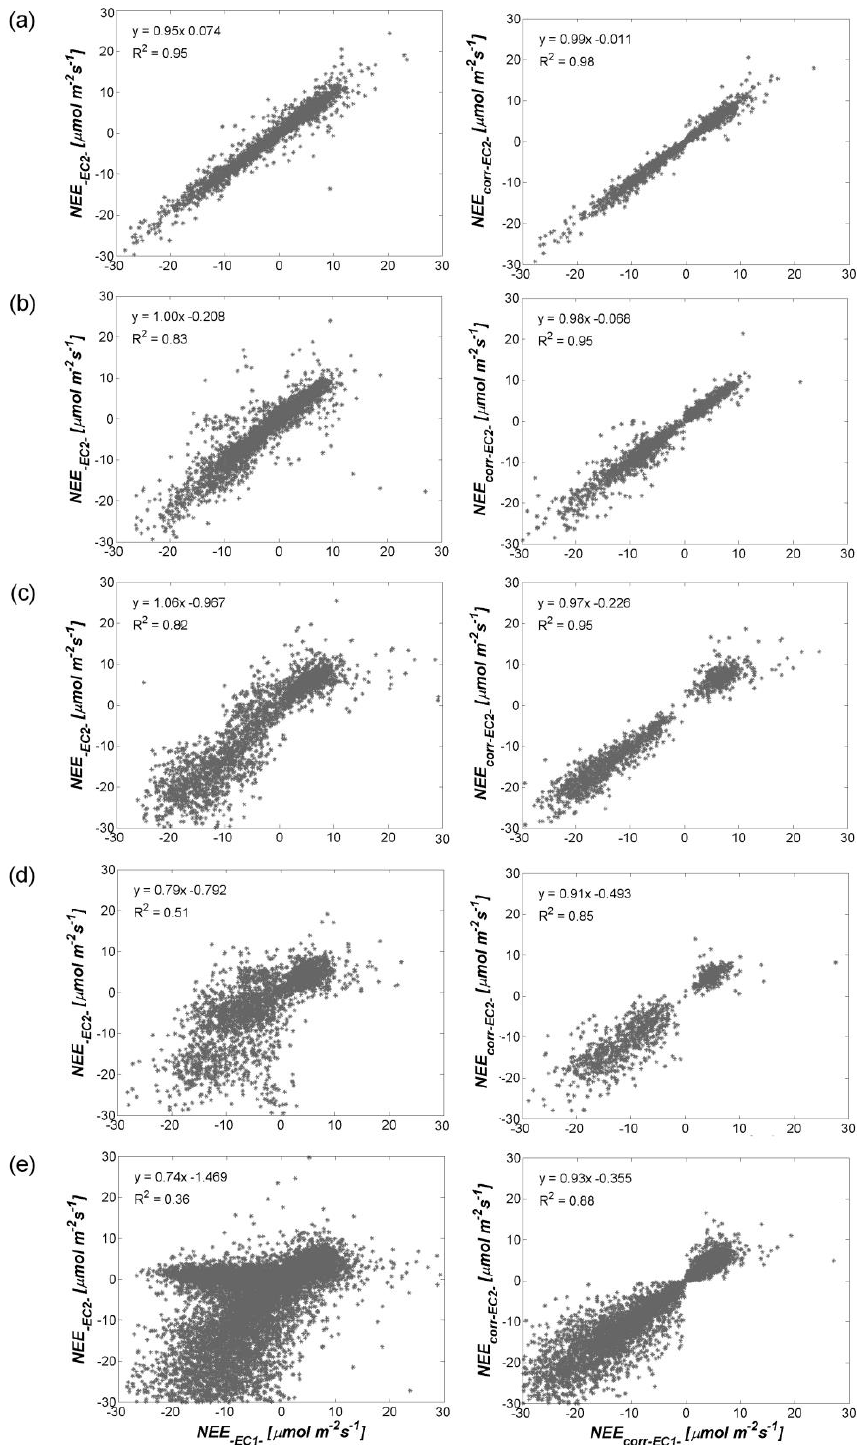
Figure 4. Scatter of the NEE measured at EC1 (NEE − EC1 − ) and NEE measured at a second tower EC2/EC3 (NEE − EC2 − ) for the un- corrected NEE (left) and the sfd-corrected NEE corr (right) for the EC tower distances 8m (a) , 95m (b) , 173m (c) , 20.5km (d) and 34km (e)